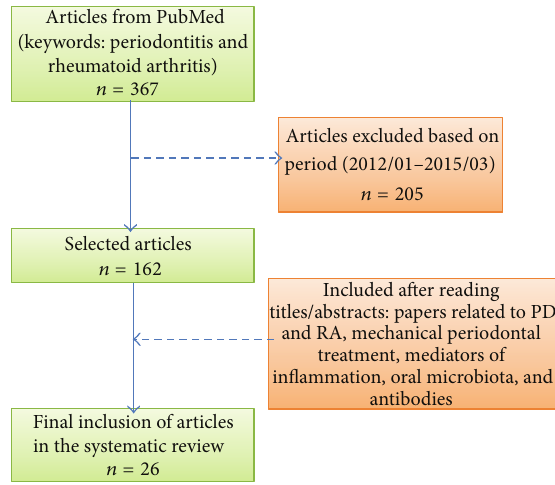
Figure2:Searchflow-chartandselectionofarticlesforthereviewof the literature considering a bit more than the last three years. PD = periodontitis; RA = rheumatoid